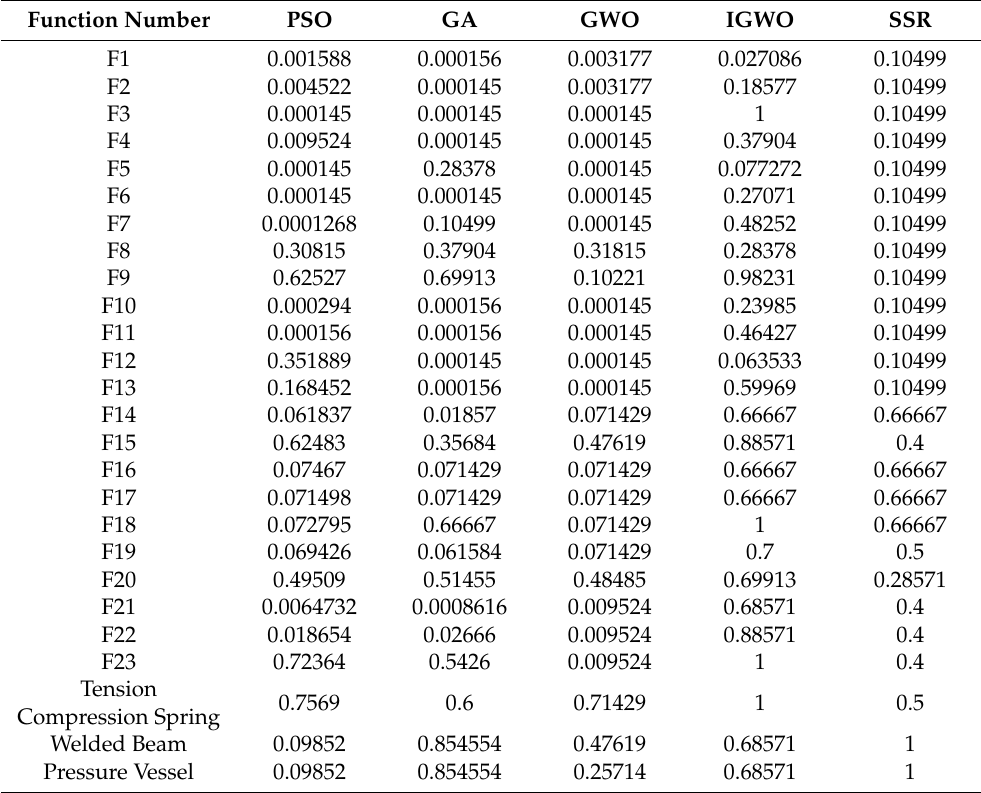
Table 13. Statistical data of functions from Tables 2–4 and engineering problem comparison with other